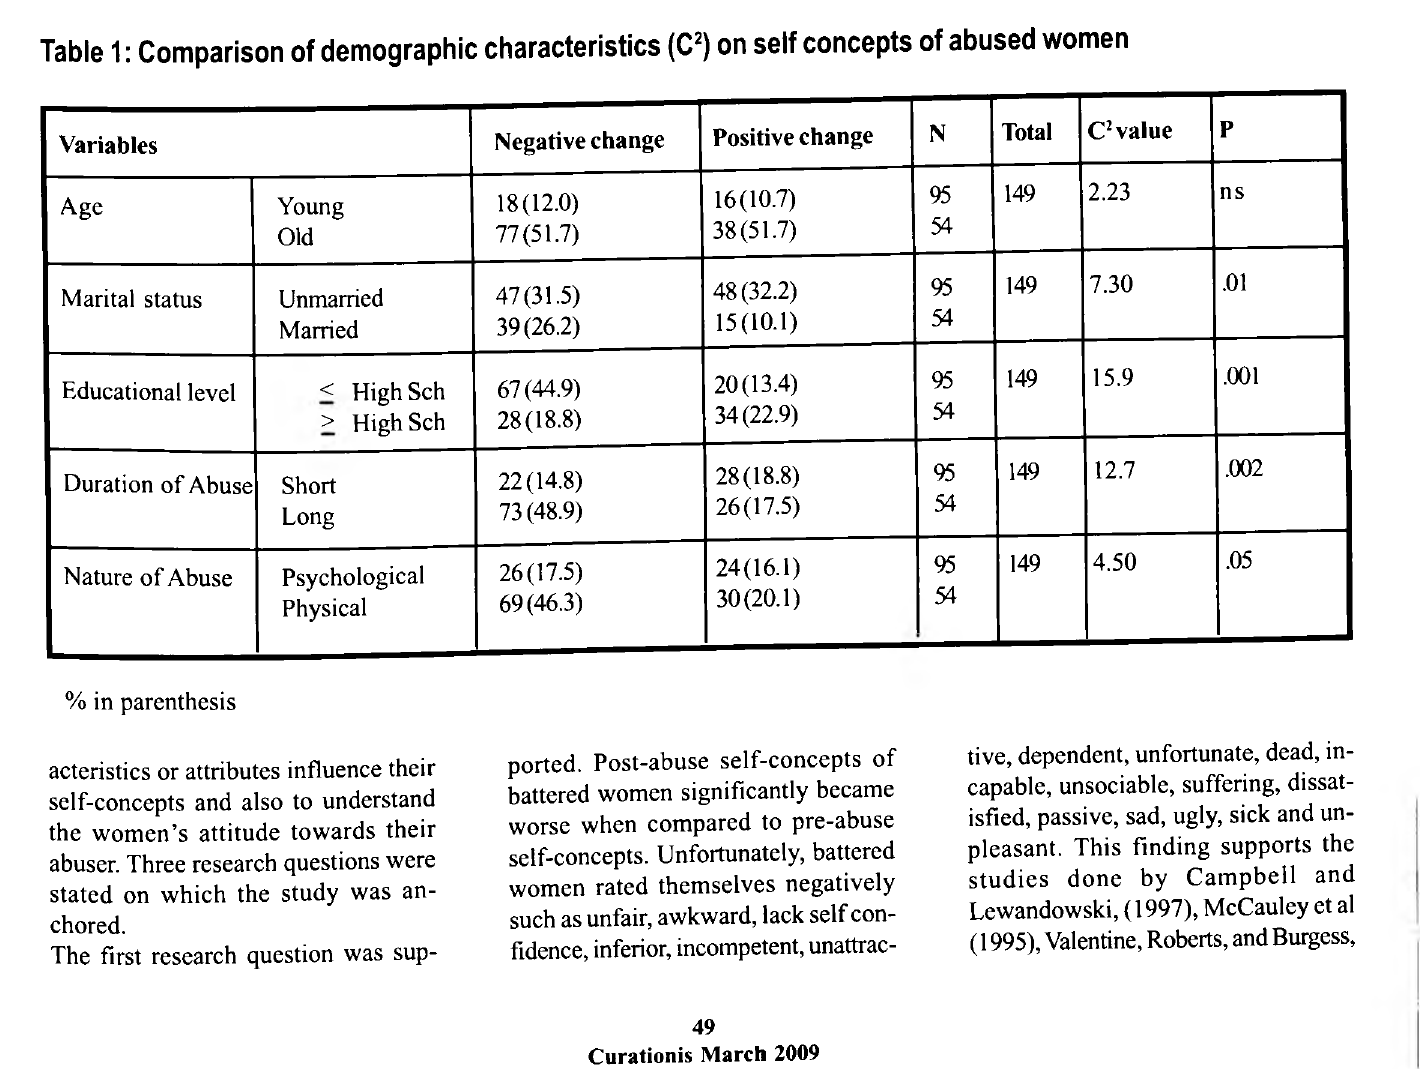
Table 1: Comparison of demographic characteristics (C2) on self concepts of abused women